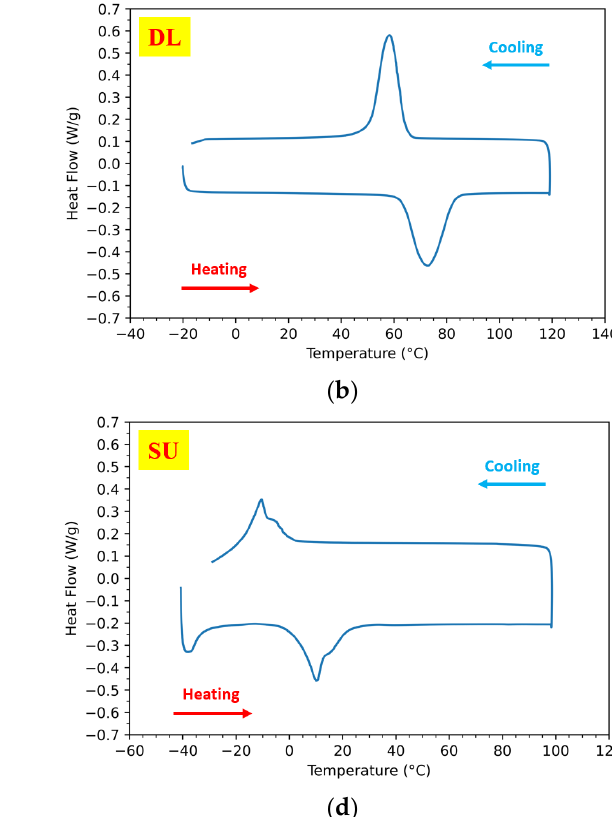
Figure 5. Vickers hardness distribution from the bottom of the TiNi substrate to the top of the DED Ti–Ni–Cu alloy. Notice that the lack of high hardness value from the hard intermetallics indicates that the major phase is the TiNi phase. Relatively higher hardness values can be observed at the lower section of the substrate from Z = 1 mm to Z = 5 mm and at the point of Z = 10 mm near the interface.